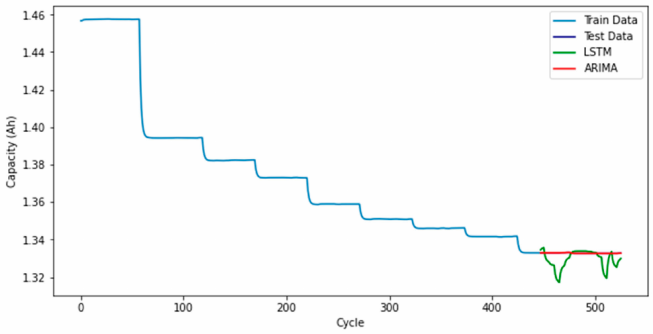
Figure 11. Train, test, and predicted data results from ARIMA and LSTM models for PL19.